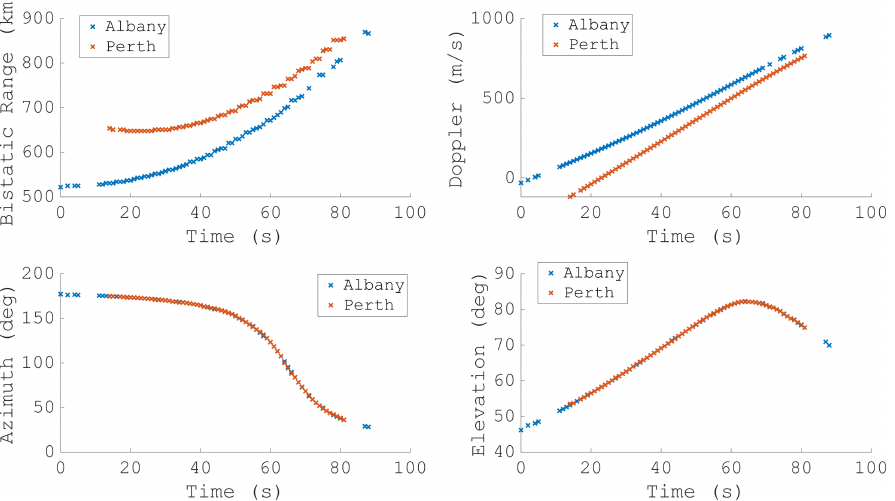
Figure 16. The four measurement parameters from the detections of COSMOS 1707 detected using FM transmitters in both Albany and